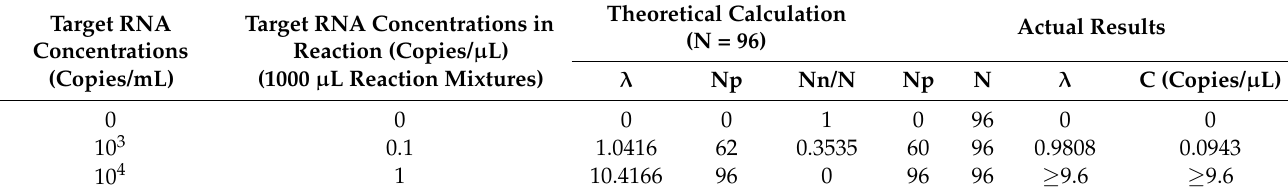
Table 3. The accuracy of the bioluminescent signal-based simulated digital LAMP